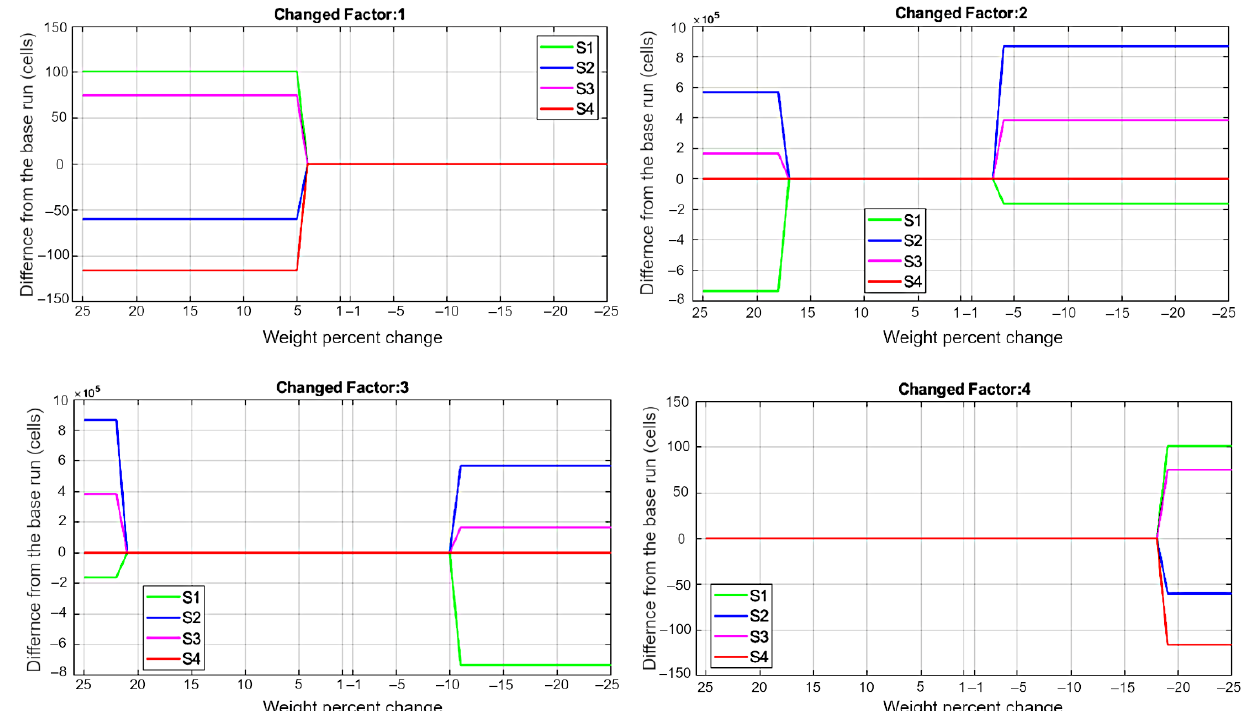
Figure 4. Soil retention capability: Cell differences compared to the base model. Summary results from 200 simulations (50 runs for each criterion). Factor 1: soil pH, factor 2: ferrallitisation, factor 3: organic matter, factor 4: soil texture. S1: no capability for Al 3+ retention in the soil, S2: little capability, S3: moderate capability, and S4: strong capability.